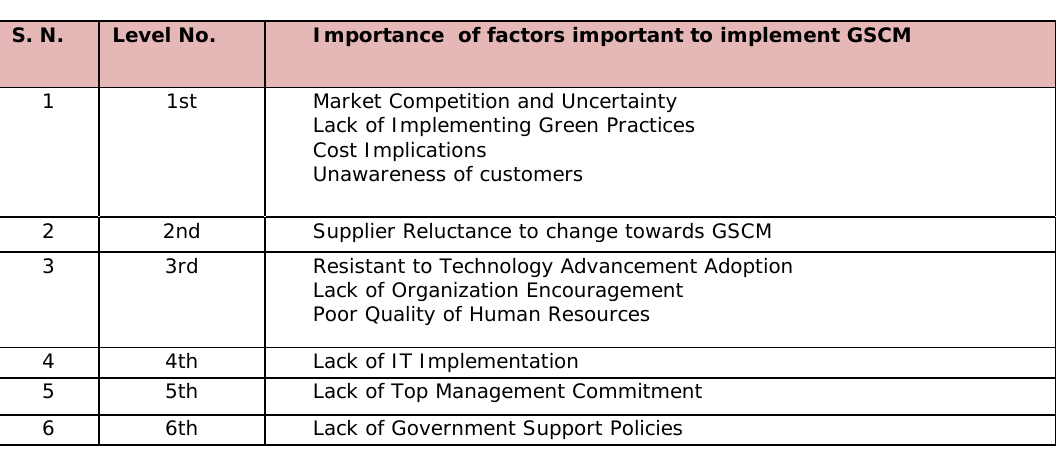
Table 7. “Various Levels of Barriers to Implement GSCM in Indian Automobile Industry”.